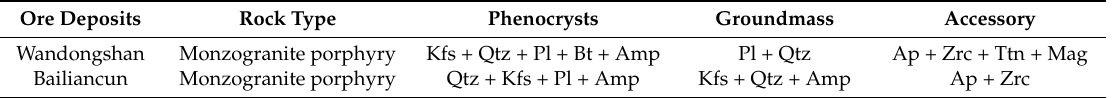
Table 1. Petrography of the monzogranite porphyry from the Wandongshan and Bailiancun ore districts. Ore Deposits